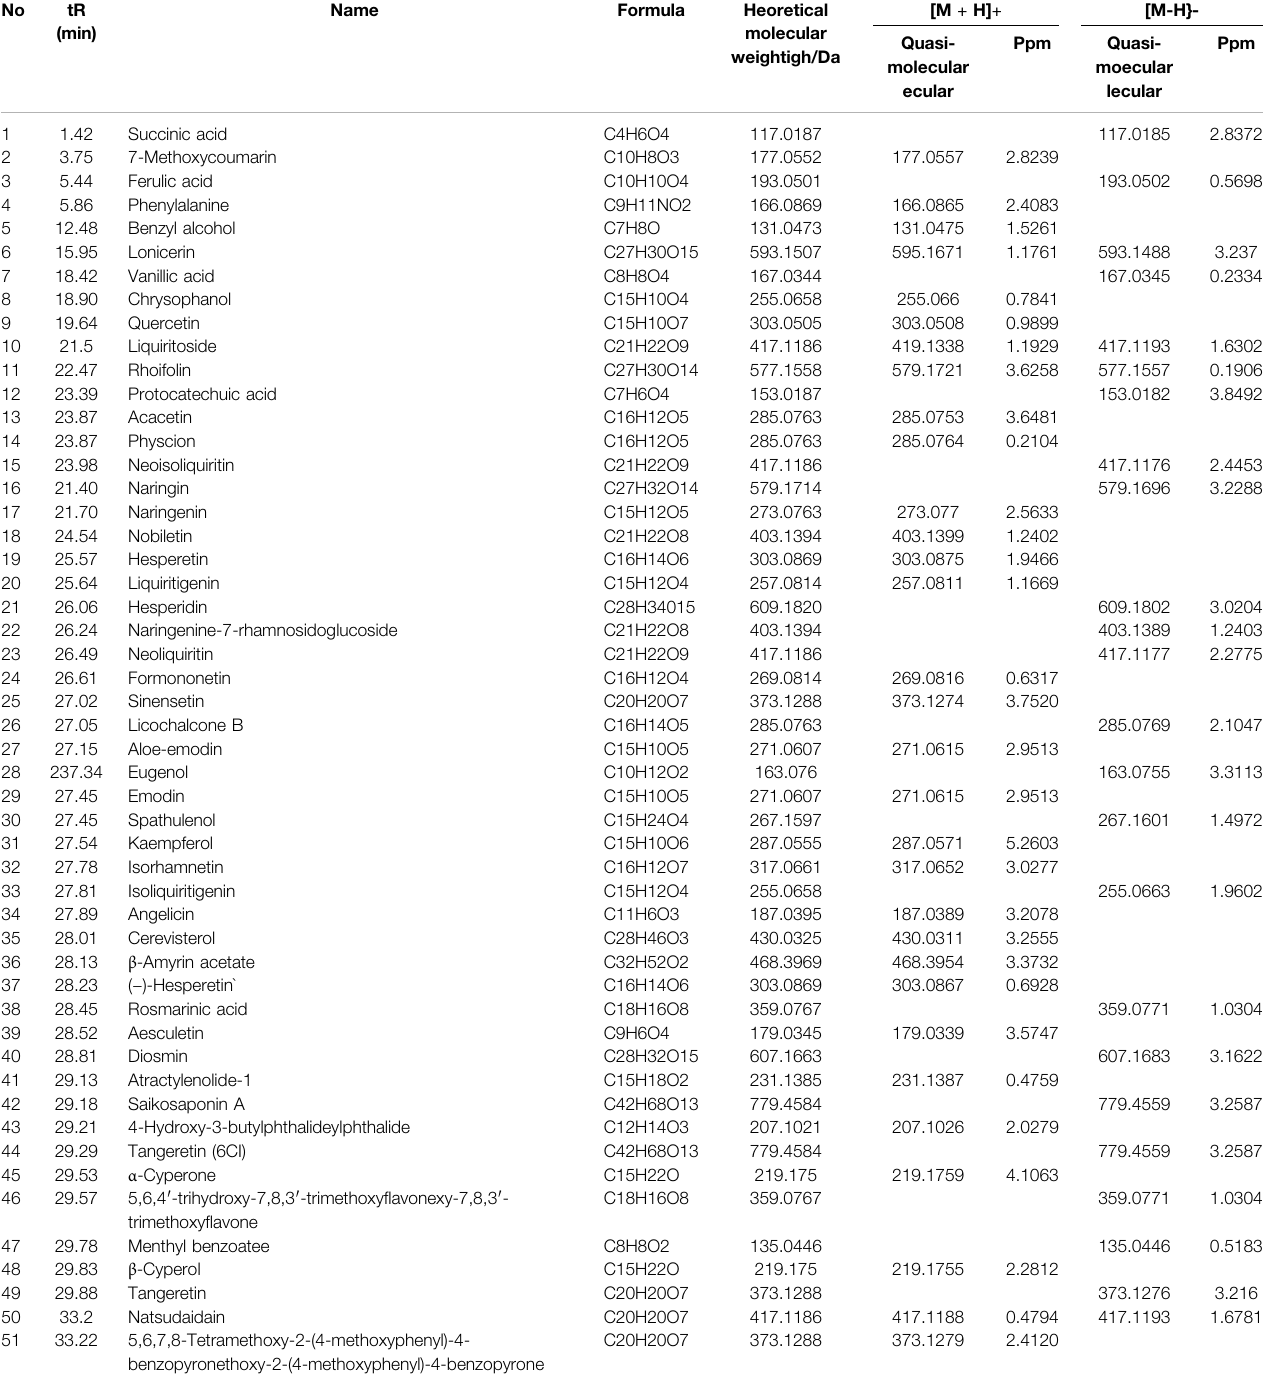
TABLE 1 | Identi fi cation of absorbed components from XPF in serum of